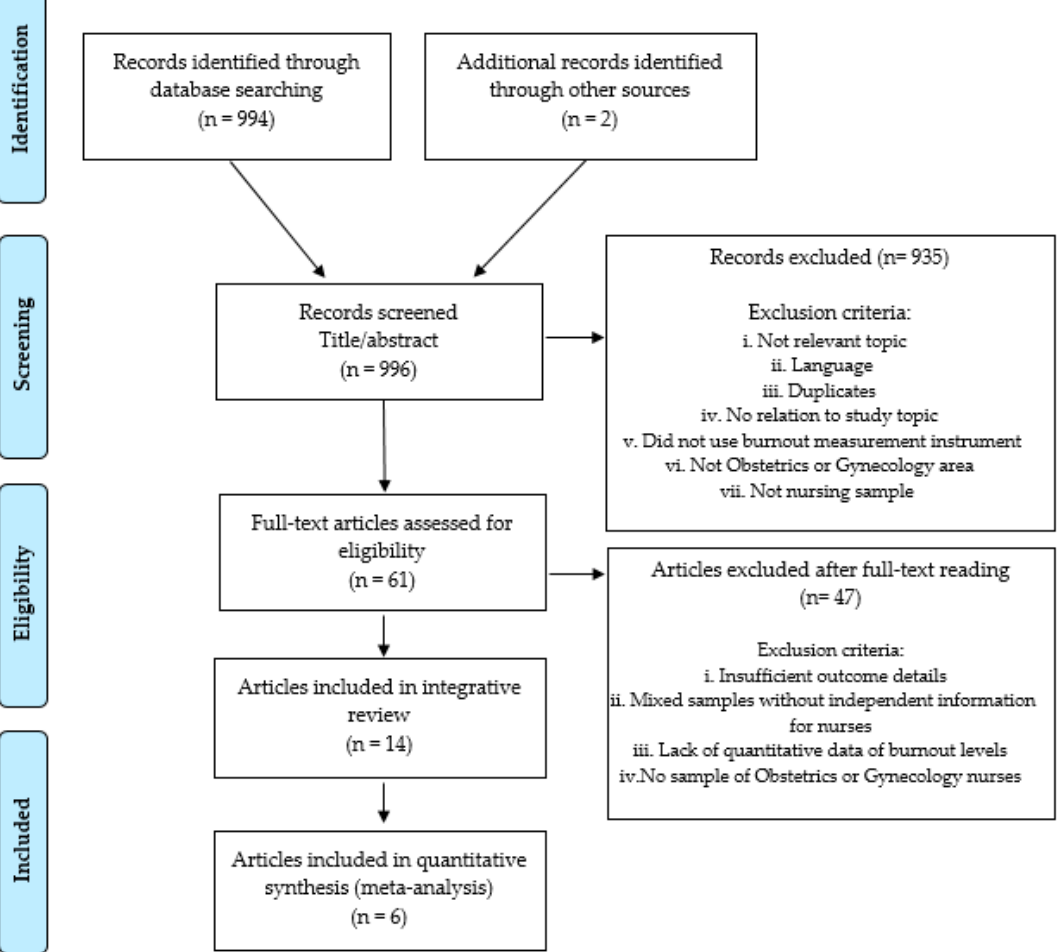
Figure 1. Study selection process to identify eligible articles for inclusion in the review and meta-